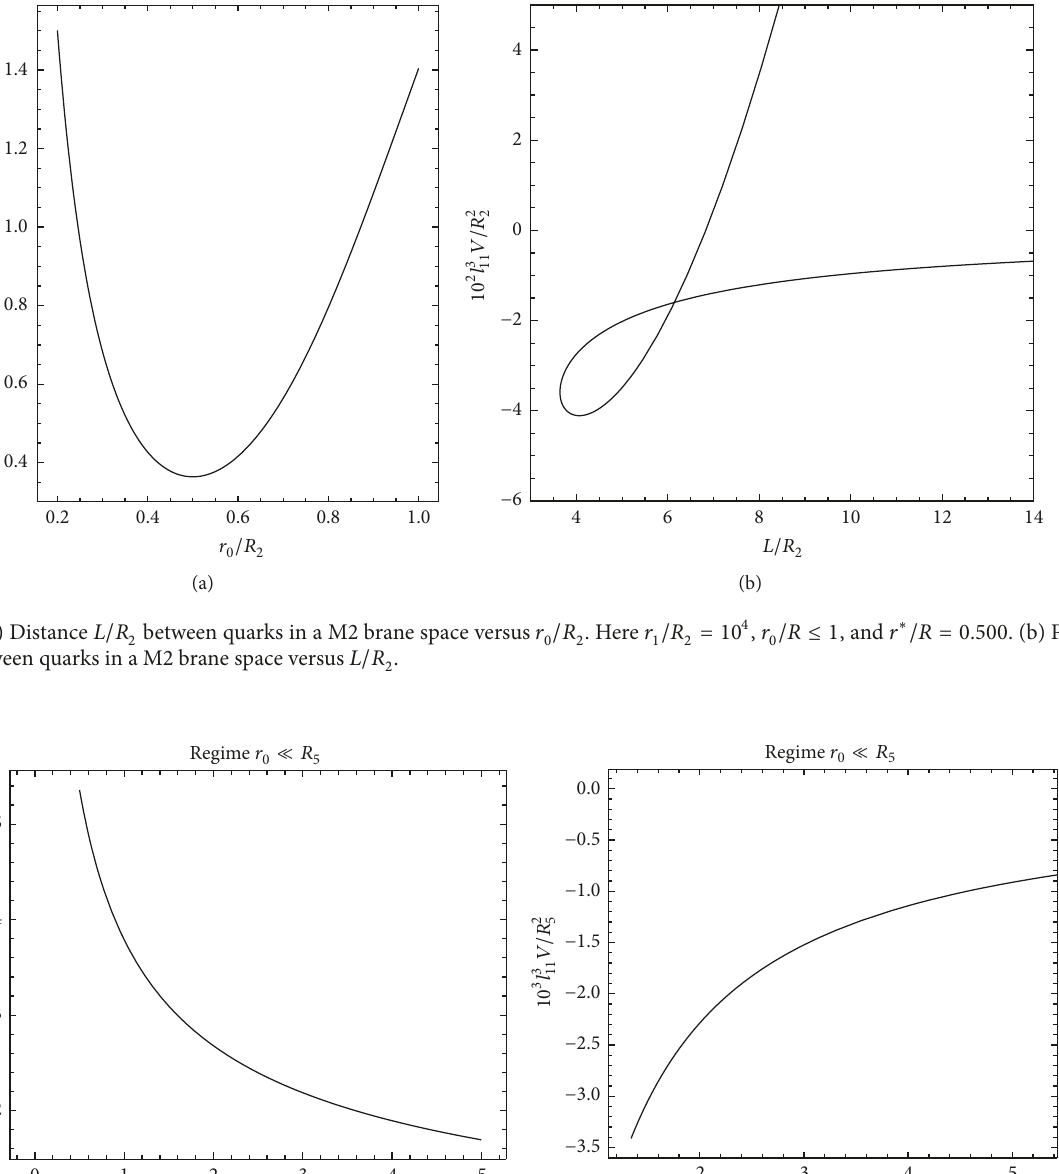
Figure 9: (a) Distance 𝐿/𝑅 5 between quarks versus 𝑟 0 /𝑅 5 . Here 𝑟 1 /𝑅 5 = 10 2 , 𝑟 0 /𝑅 5 < 5 × 10 −5 . (b) Potential 𝑙 3 11 𝑉/𝑅 2 5 between quarks in a M5 brane space versus the distance 𝐿/𝑅 5 . Here 𝑟 1 /𝑅 5 = 10 2 and 𝑟 0 /𝑅 5 < 8 × 10 −5